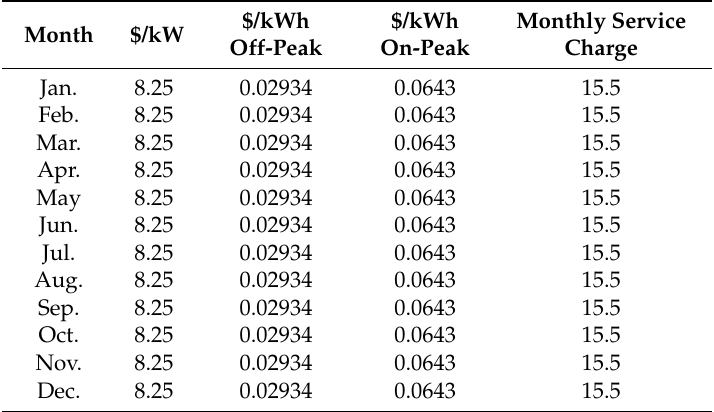
Table 3. Price plan for the state